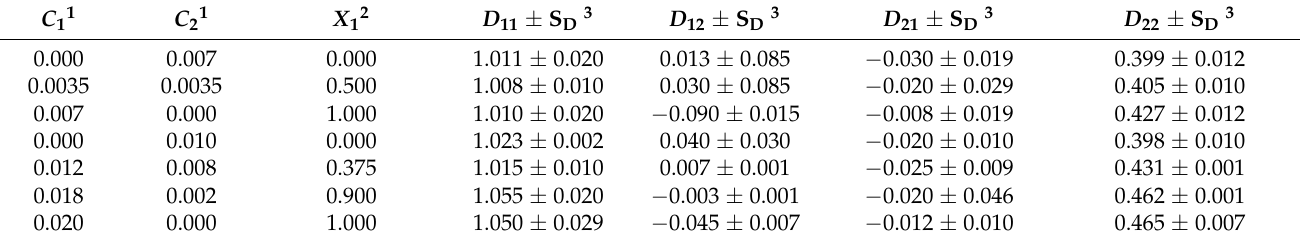
Table 2. Experimental ternary diffusion coefficients ( D 11 , D 12 , D 21 , D 22 ) of 5-FU ( C 1 ) + β -CD ( C 2 ) aqueous solutions at T = 298.15 K and P = 101.3